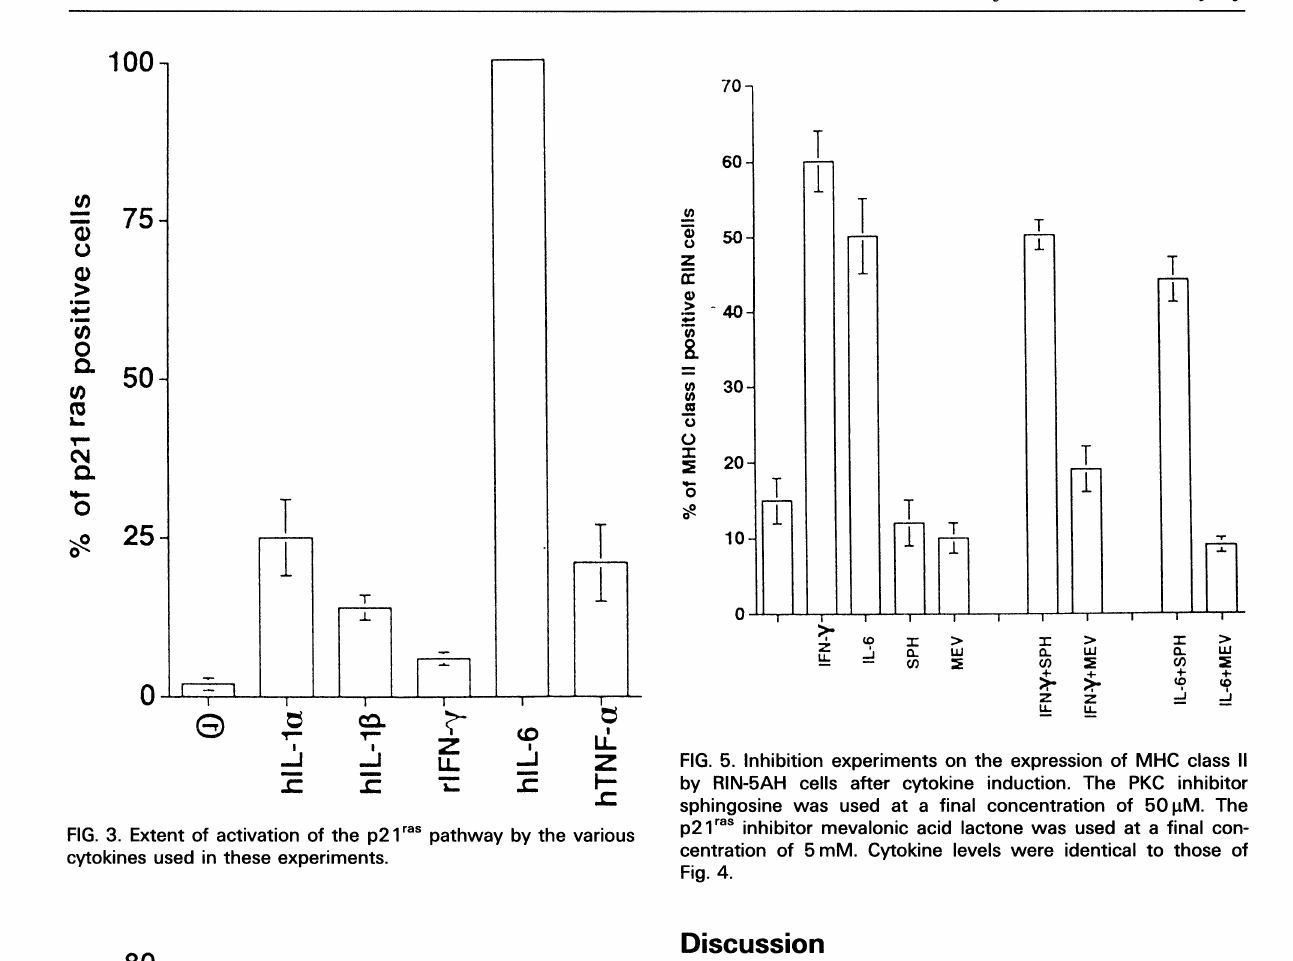
FIG. 3. Extent of activation of the p2 lras pathway by the various cytokines used in these experiments.